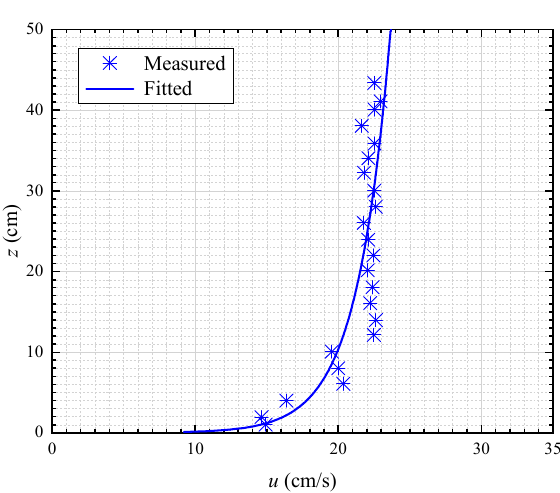
Figure 2. Velocity distributions along the flow depth.